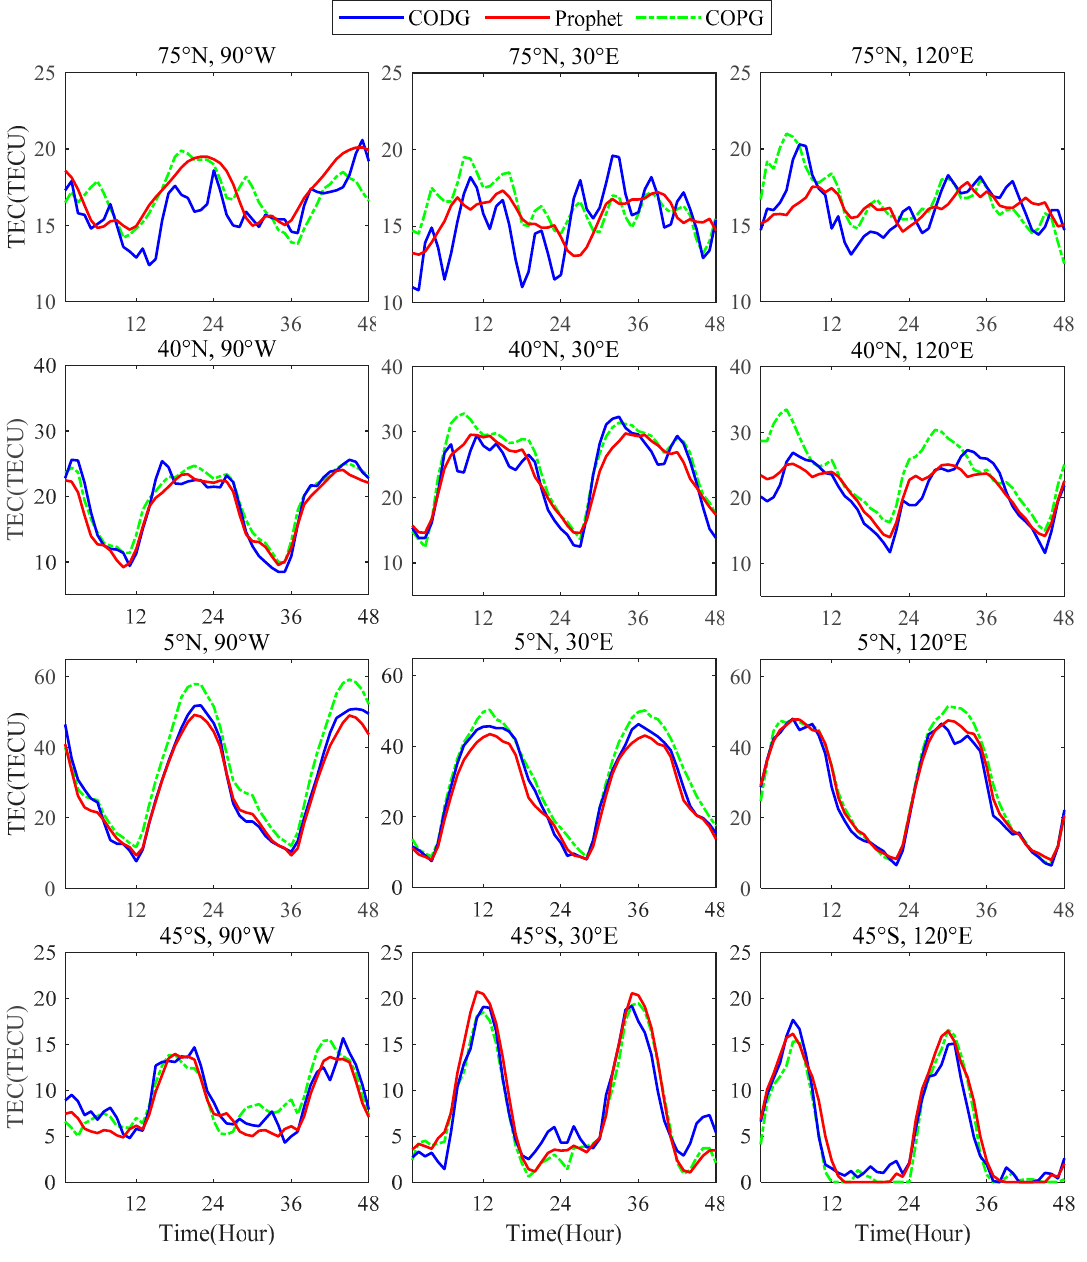
Figure 12. Comparison of how CODG, Prophet forecasted, and COPG values at different latitudes and longitudes change over time. The blue solid lines represent the CODG values, the red solid lines represent the Prophet forecasted values, and the green dashed lines represent the COPG values. Table 3. Accuracy comparison of the Prophet and COPG models at different latitudes at longitude 120° E.